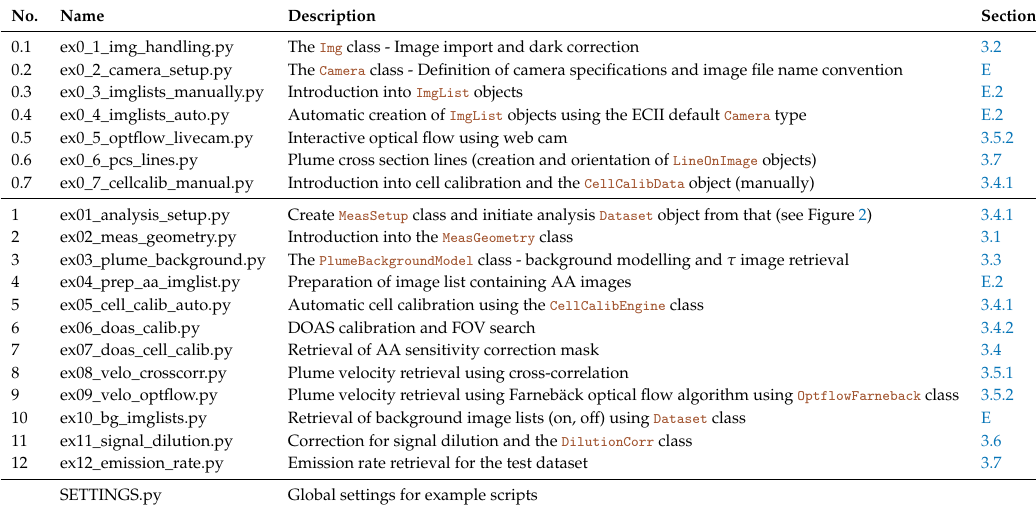
Table A2. Pyplis example scripts, sub-categorised into introductory scripts (0.1–0.7) and scripts related to the emission rate analysis of the Etna test data